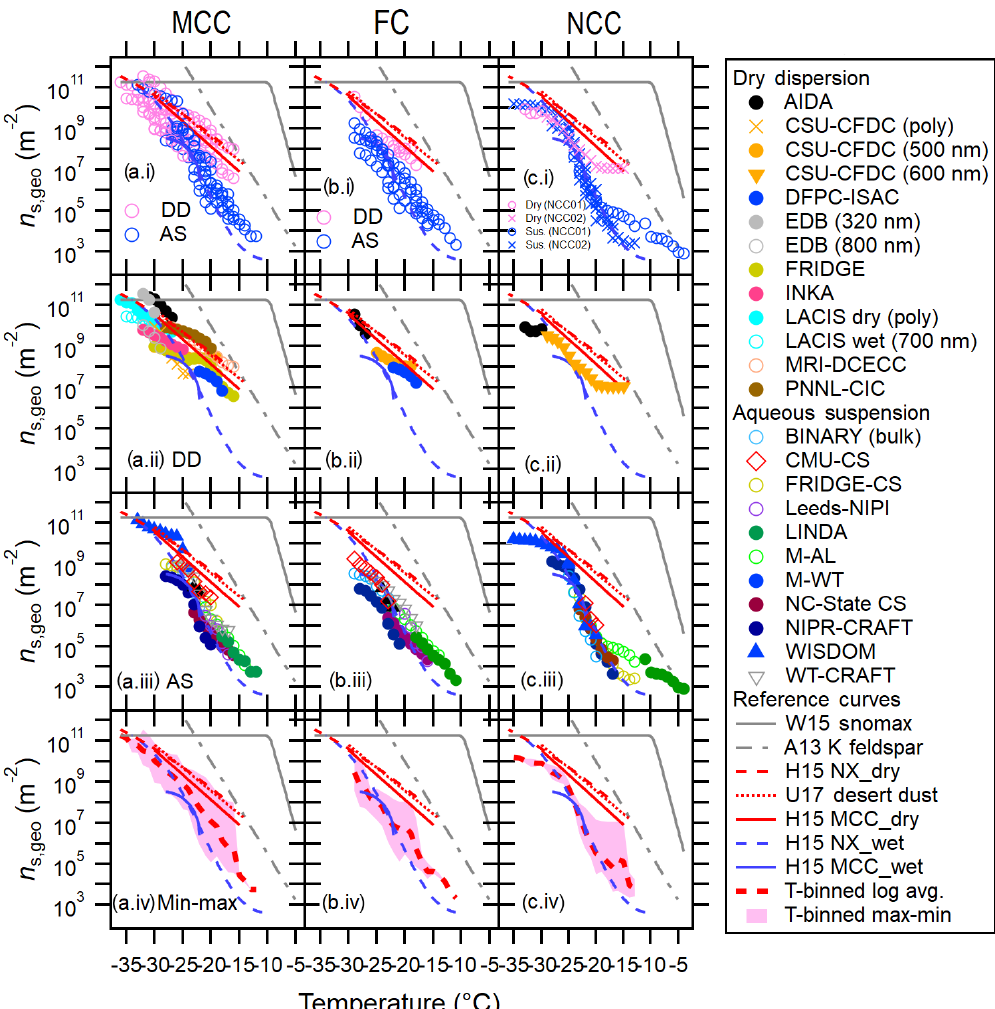
Figure 1. Immersion freezing n s , geo (T ) spectra for MCC (a) , FC (b) and NCC (c) from different techniques. Dry dispersion results (DD, pink markers) and aqueous suspension results (AS, blue markers) are shown in (a.i–c.i) to highlight the difference between these two subsets. Intercomparisons of DD and AS for each cellulose sample type using T -binned n s , geo are presented in (a.ii–c.ii) and (a.iii–c.iii) , respectively. The log average of all results as well as the deviation between maxima and minima of n s , geo (T ) are shown in (a.iv–a.iv) . Reference immersion freezing n s (T ) spectra for MCC (H15a) illite NX (H15b), Snomax (Wex et al., 2015), desert dusts (U17; Ullrich et al., 2017) and K feldspar (A13; Atkinson et al., 2013) are also shown (see Sect. 4.1). For NCC, the results from two different batches (NCC01 from December 2014 and NCC02 from May 2015) are